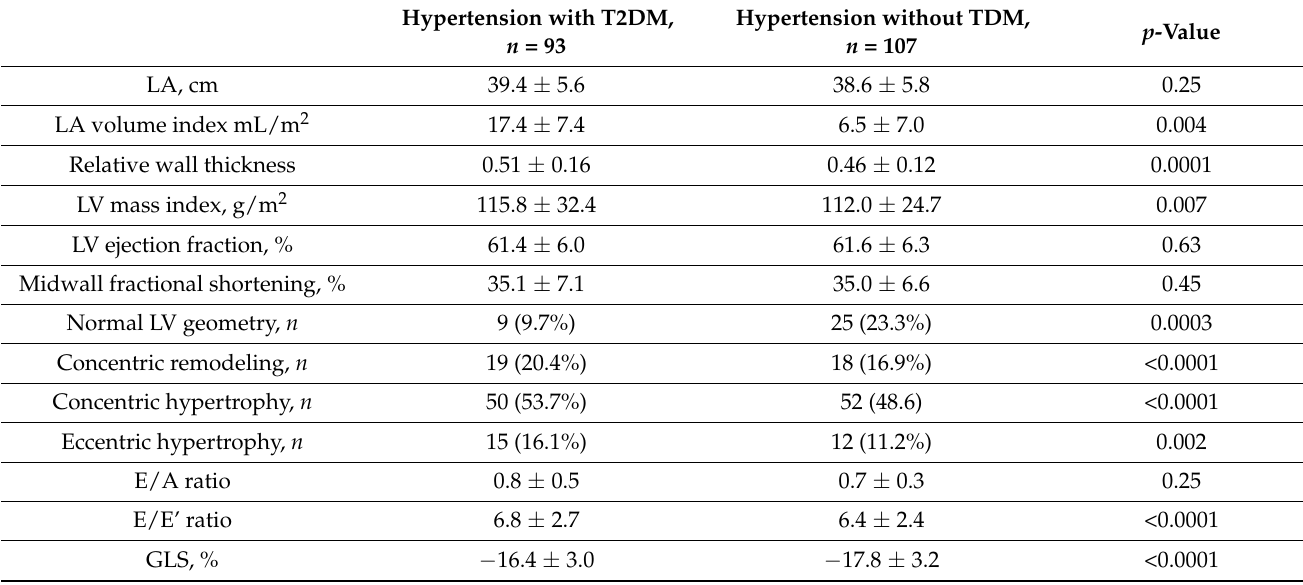
Table 2. Echocardiographic characteristics of the study